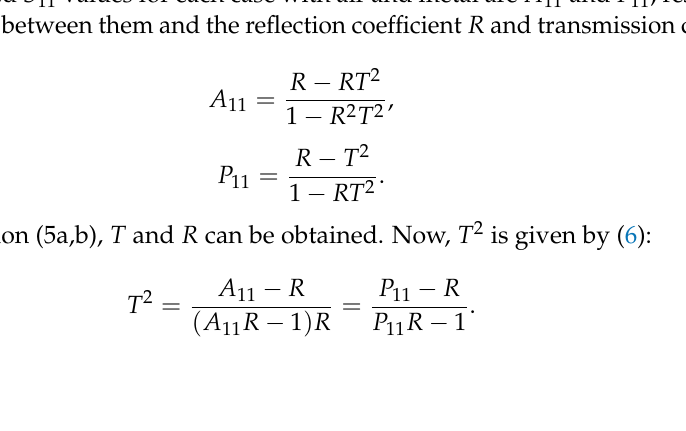
Figure 6. Measurements of two reflection cases. ( a ) Air-back case. ( b ) Metal-back case. The measured S 11 values for each case with air and metal are A 11 and P 11 ,